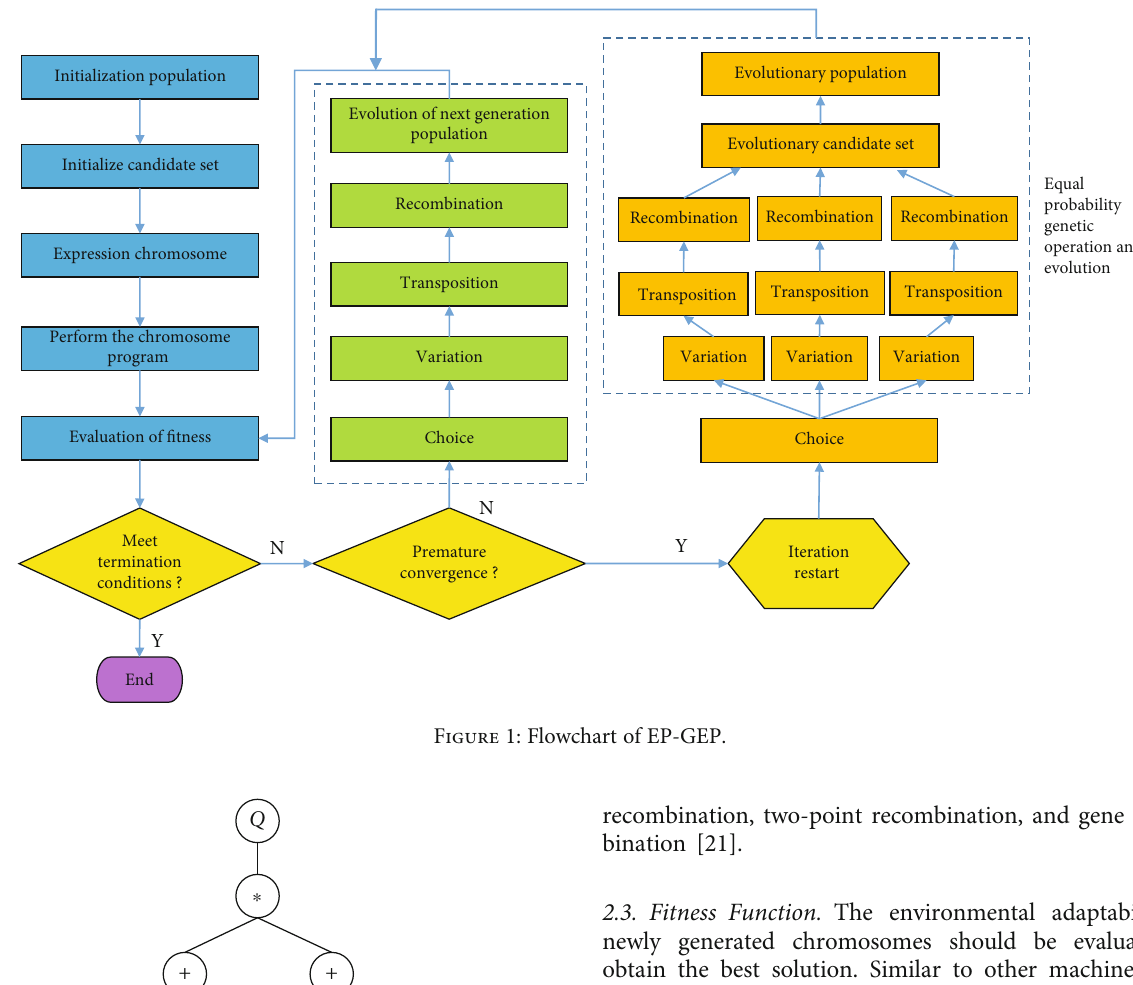
Figure 1: Flowchart of EP-GEP.